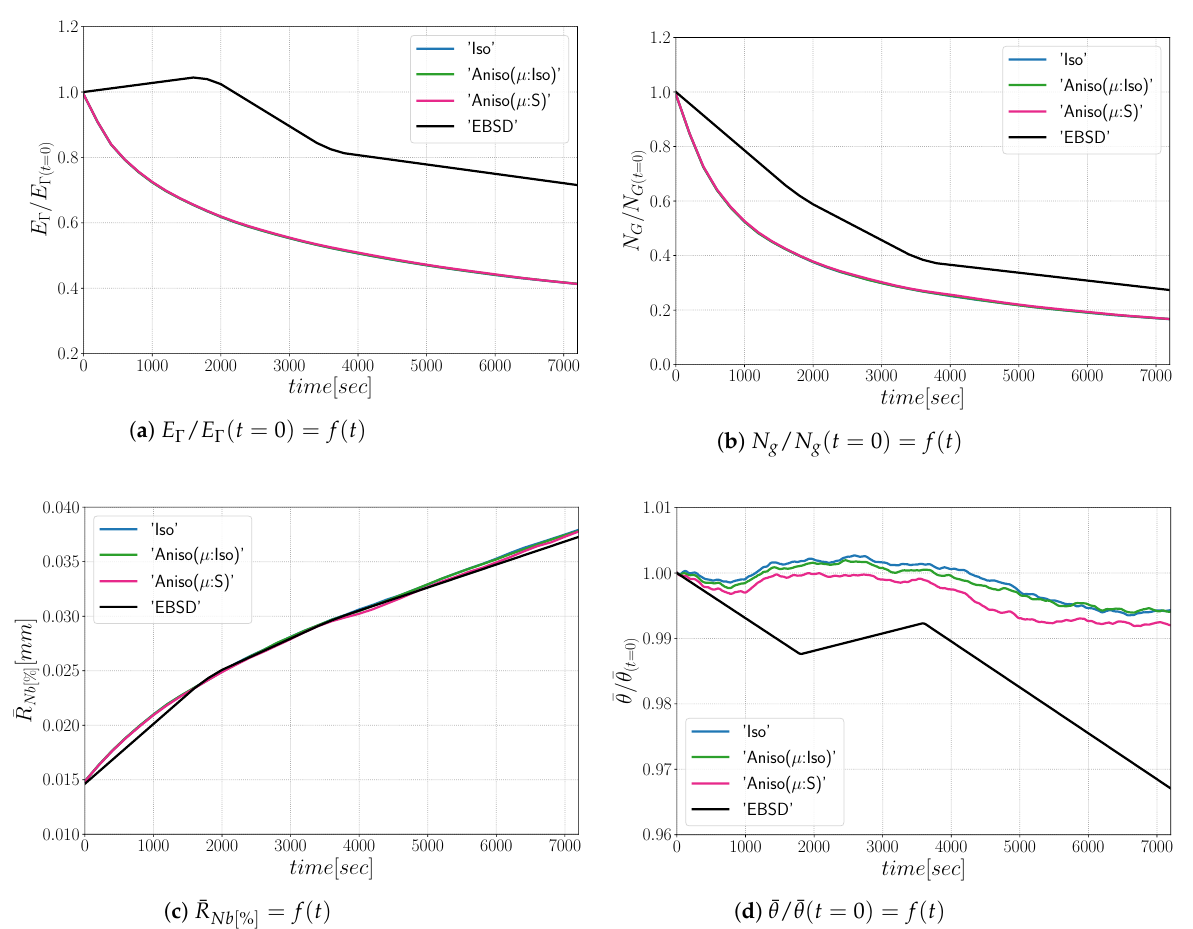
Figure 9. Mean values time evolution for the isotropic (Iso) formulation, anisotropic formulations with isotropic GB mobility (Aniso( µ :Iso)) and heterogeneous GB mobility (Aniso( µ :S)) and the experimental data (EBSD). Numerical results obtained from the initial microstructure shown in Figure